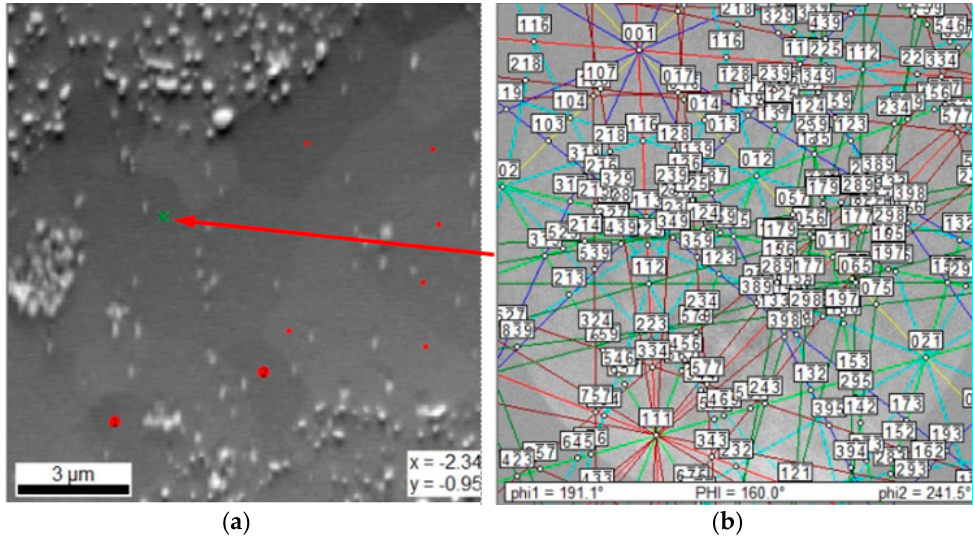
Figure 6. An example of a large light phase area (lb) subjected to EBSD microdiffraction ( a ) in the form of the Kikuchi line for the BCC crystal lattice with the lattice parameter oscillating around the value characteristic for the manganese lattice ( b ).